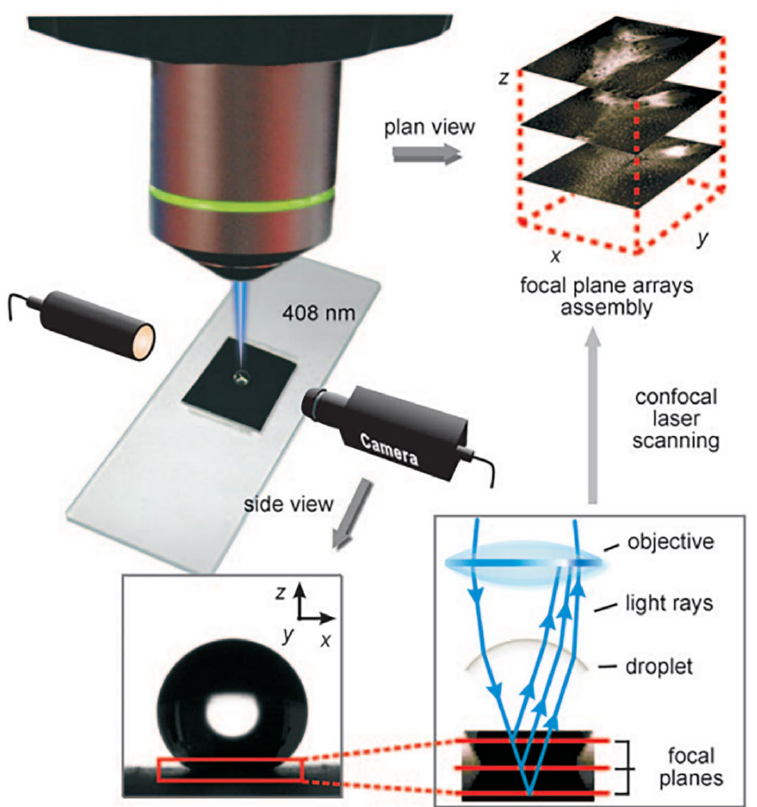
Figure 12. Schematic illustration for the CLSM methodology. Side view and the CLSM 3D plan view for observing a droplet on a superhydrophobic surface sheet. Reprinted with permission from Ref. [116]. Copyright@2010, Wiley-VCH Verlag GmbH & Co. KGaA, Weinheim.